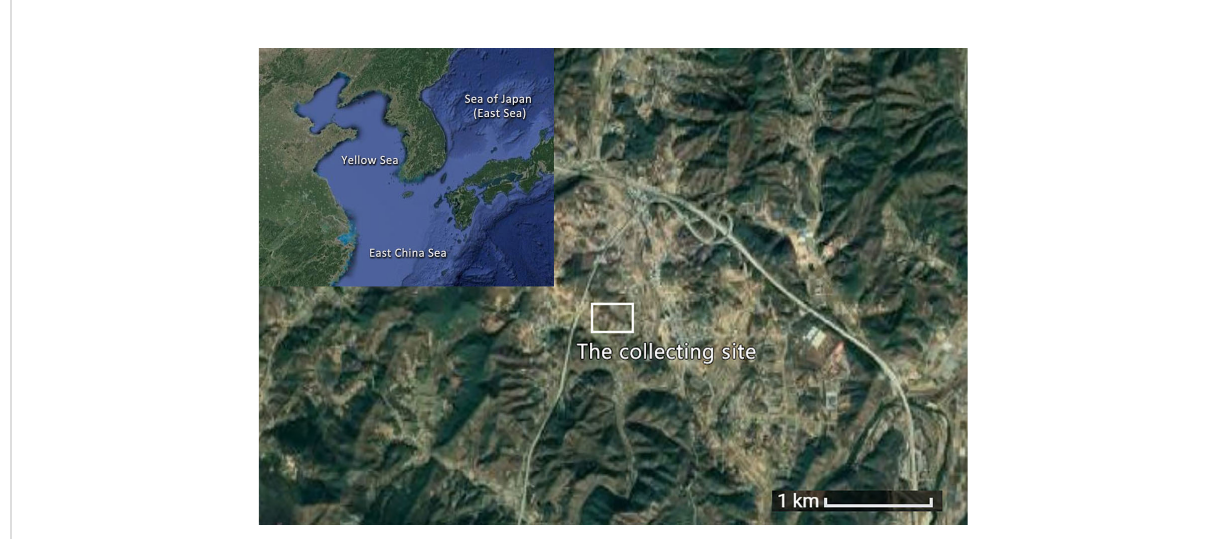
FIGURE 2 Geographical location of acorn collection